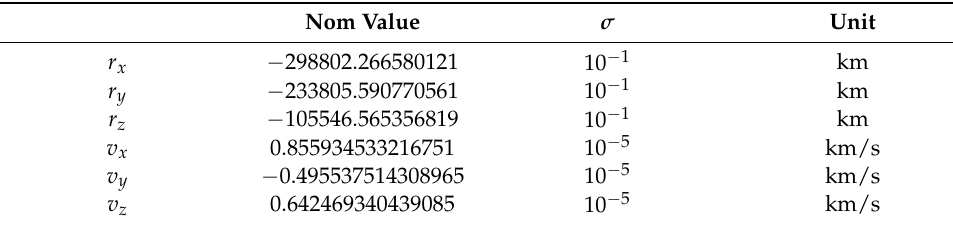
Table 8. Asteroid 2012 TF79’s pre-flyby state and associated σ values.